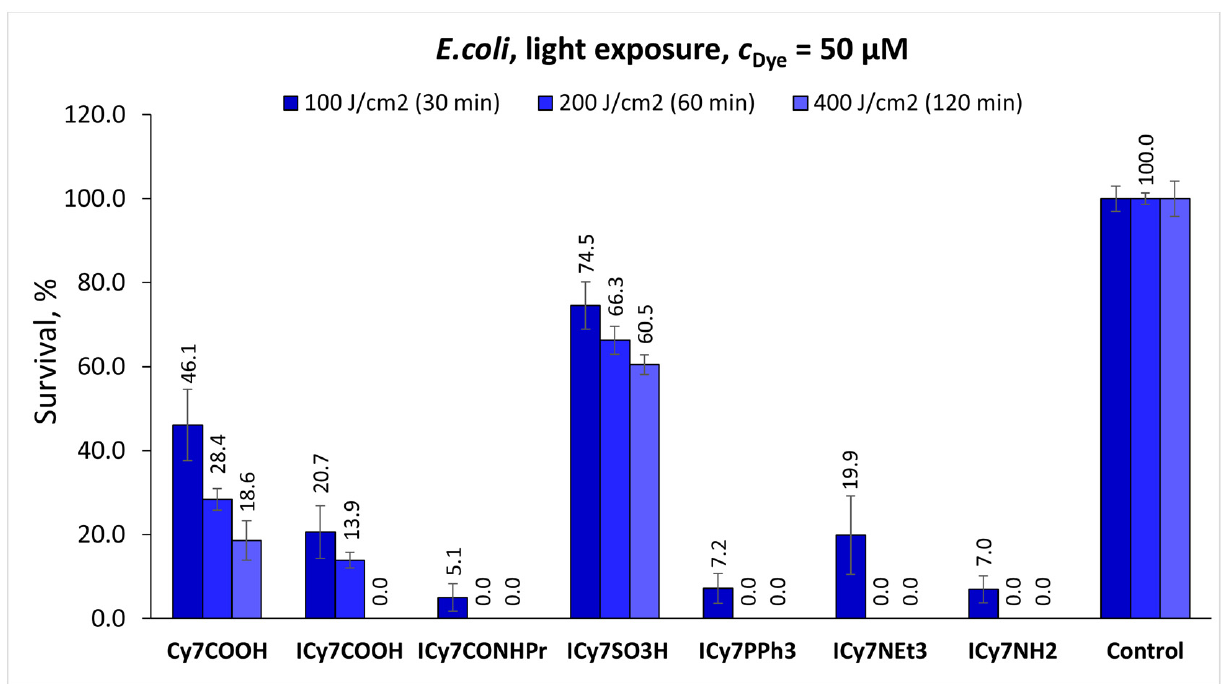
Figure 6. Survival of E. coli at ( c Dye = 50 µM in saline containing 0.7% DMSO), when exposed to 100 J/cm 2 (30 min), 200 J/cm 2 (60 min), and 400 J/cm 2 (120 min) light doses.